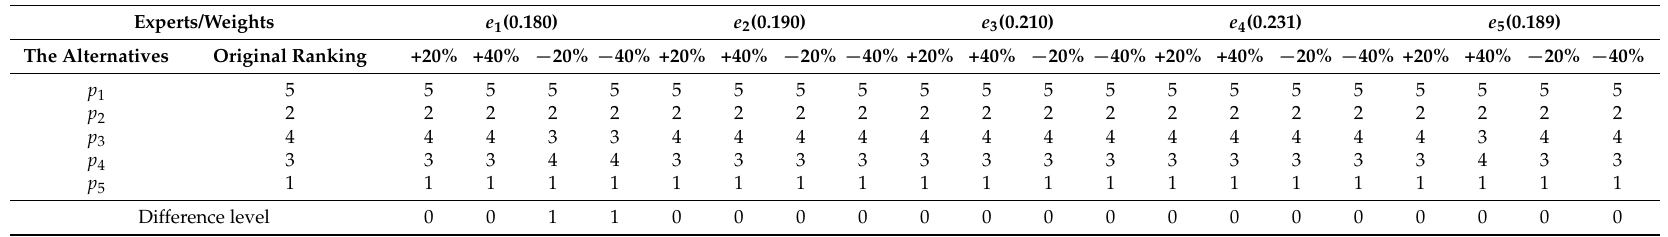
Table 7. Difference level between the original ranking and the adjusted ranking obtained based on the changing expert weights.